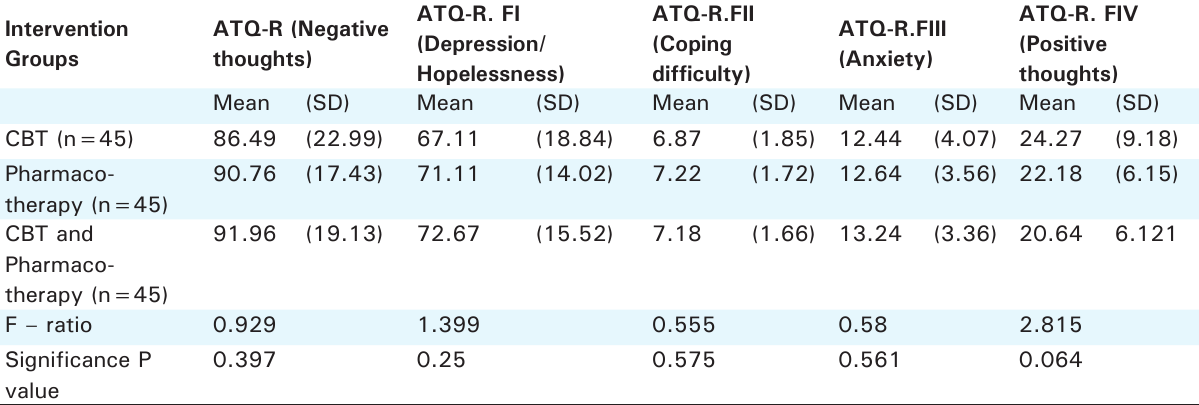
Table 3. Pre-therapy assessment of automatic thoughts among the intervention groups (Mean and SD). Intervention